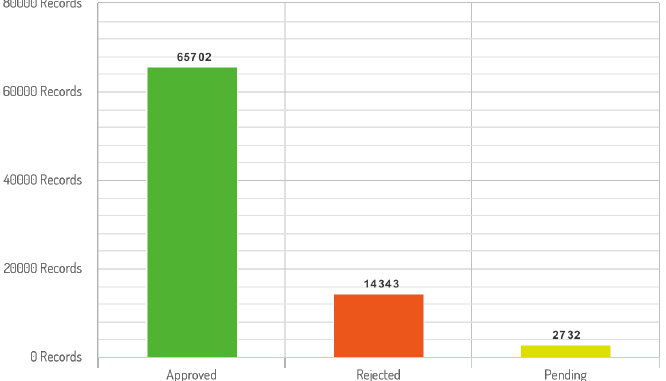
Figure 7. Classes distribution of the original data set.